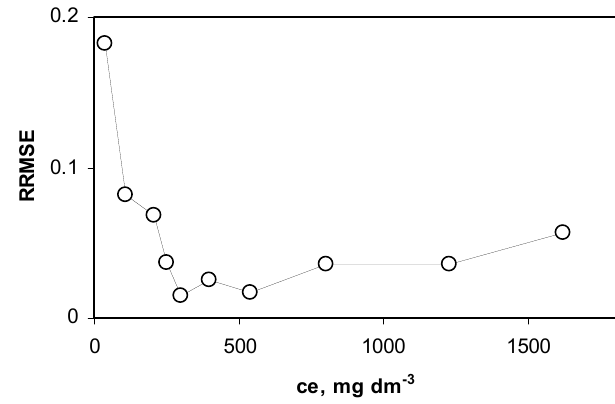
Figure 8. Relative root mean square error (RRMSE) values for approximation of adsorption data by the Langmuir equation.